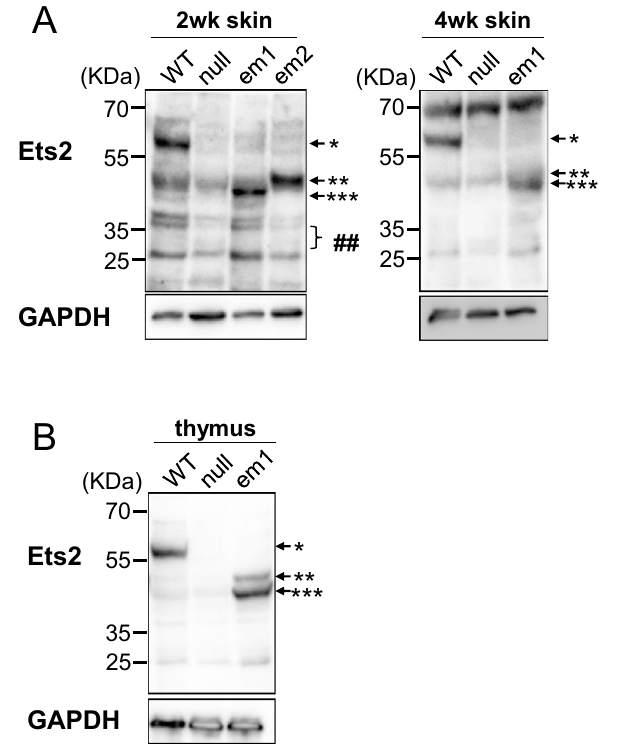
Figure 5. Presence of proteins in the Ets2 mutant skin and thymus. Western blotting with anti-Ets2 antibody and anti-Gapdh antibody in the skin (A) and thymus (B) . Native Ets2 protein (*) was detected only in WT samples. Ets2 ΔEx8 (**) and Ets2 em1 (***) mutant proteins were not detected in WT and null mutant samples. Ets2 em2 mutant protein (the predicted size indicates as ##) were not detected in Ets2 em2/em2 (em2)